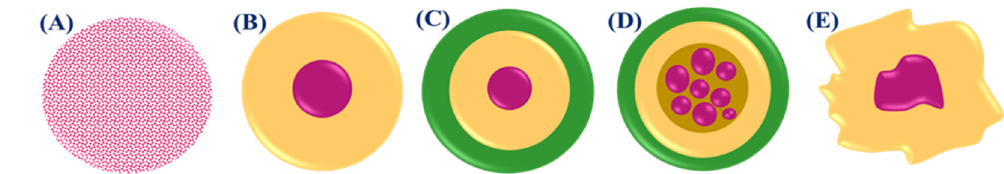
Figure 2. Schematic illustration of various morphologies formed by microencapsulation: microsphere ( A ), monolayer and mononuclear microcapsule ( B ), multilayer and mononuclear microcapsule ( C ), multilayer and multinuclear microcapsule ( D ), and microparticle ( E ).